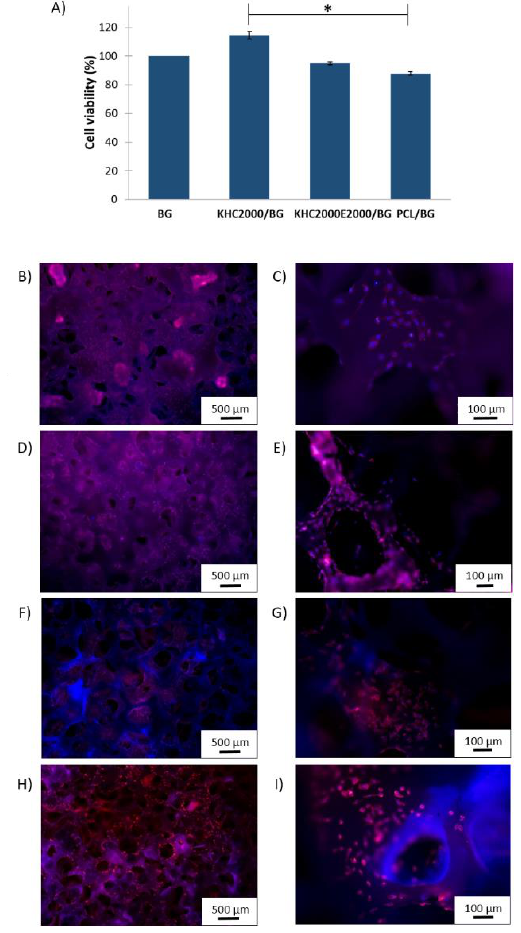
Figure 14. ( A ) Cell viability evaluated using WST-8 assay (BG scaffolds were used as control samples). Fluorescent images of ( B , C ) BG; ( D , E ) PCL/BG; ( F , G ) KHC2000/BG and ( H , I ) KHC2000E2000/BG scaffolds. Cell actin filaments and nuclei were stained with Rhodamine Phalloidin (red) and DAPI (blue),